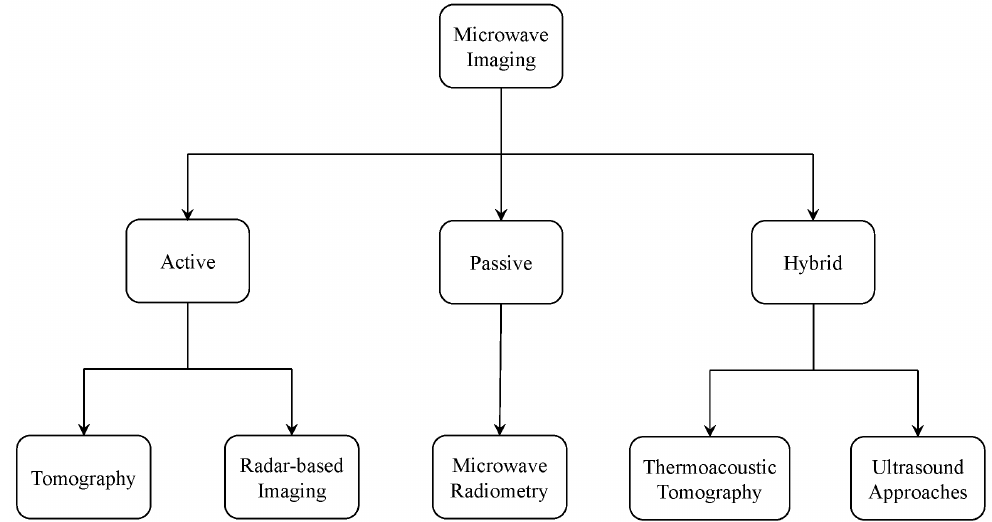
Figure 2. Different approaches used for near-field microwave